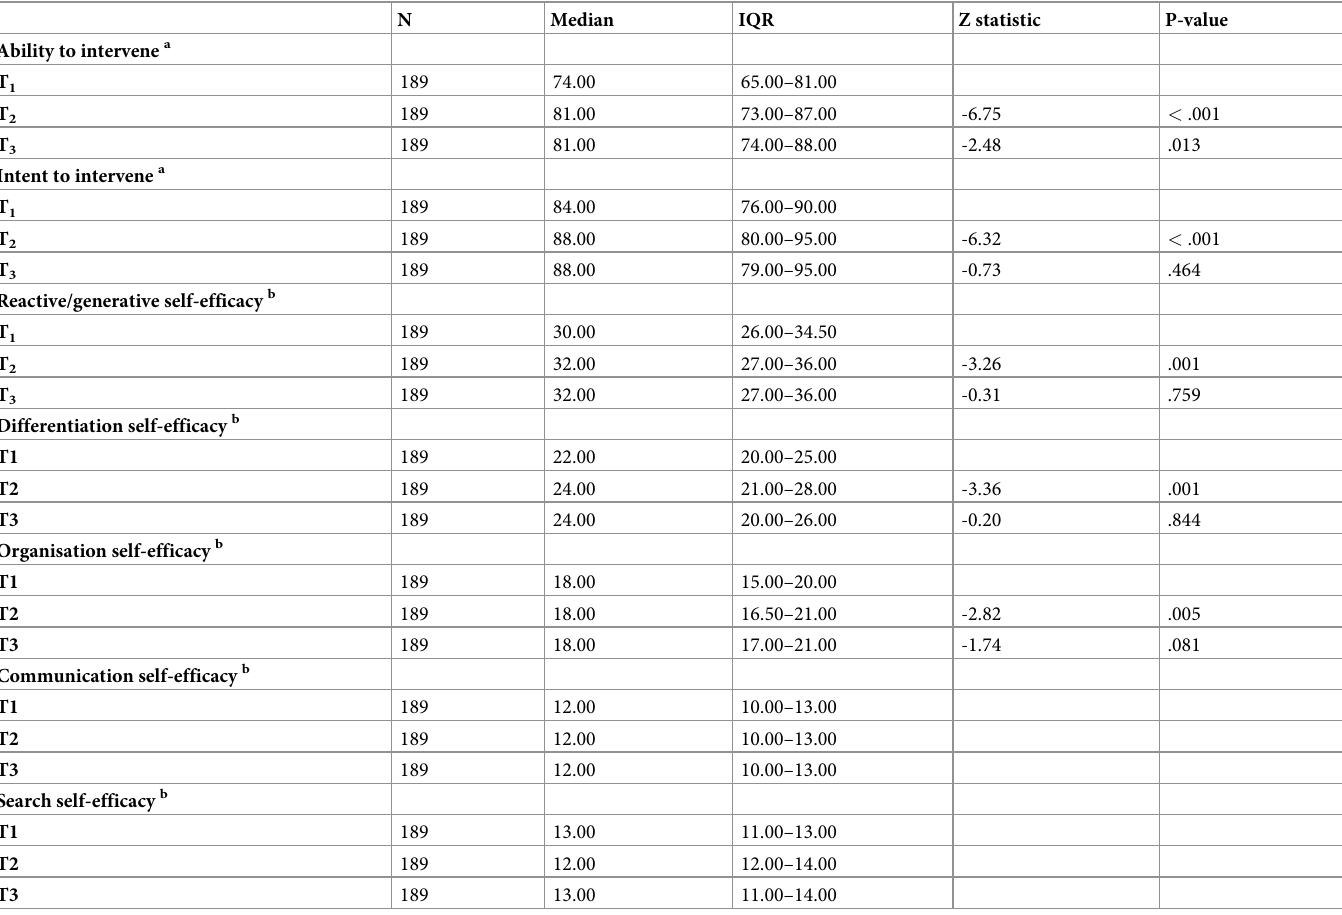
Table 4. Ability and willingness to intervene against suicide online and internet self-efficacy for the entire